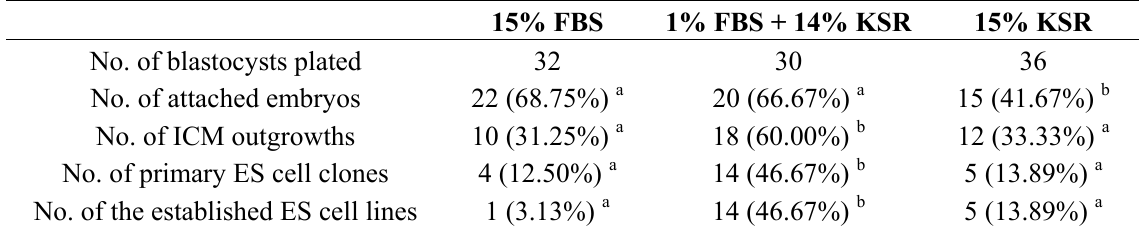
Table 2. Effects of fetal bovine serum (FBS) and knockout serum replacement (KSR) on establishment of embryonic stem (ES) cell lines.